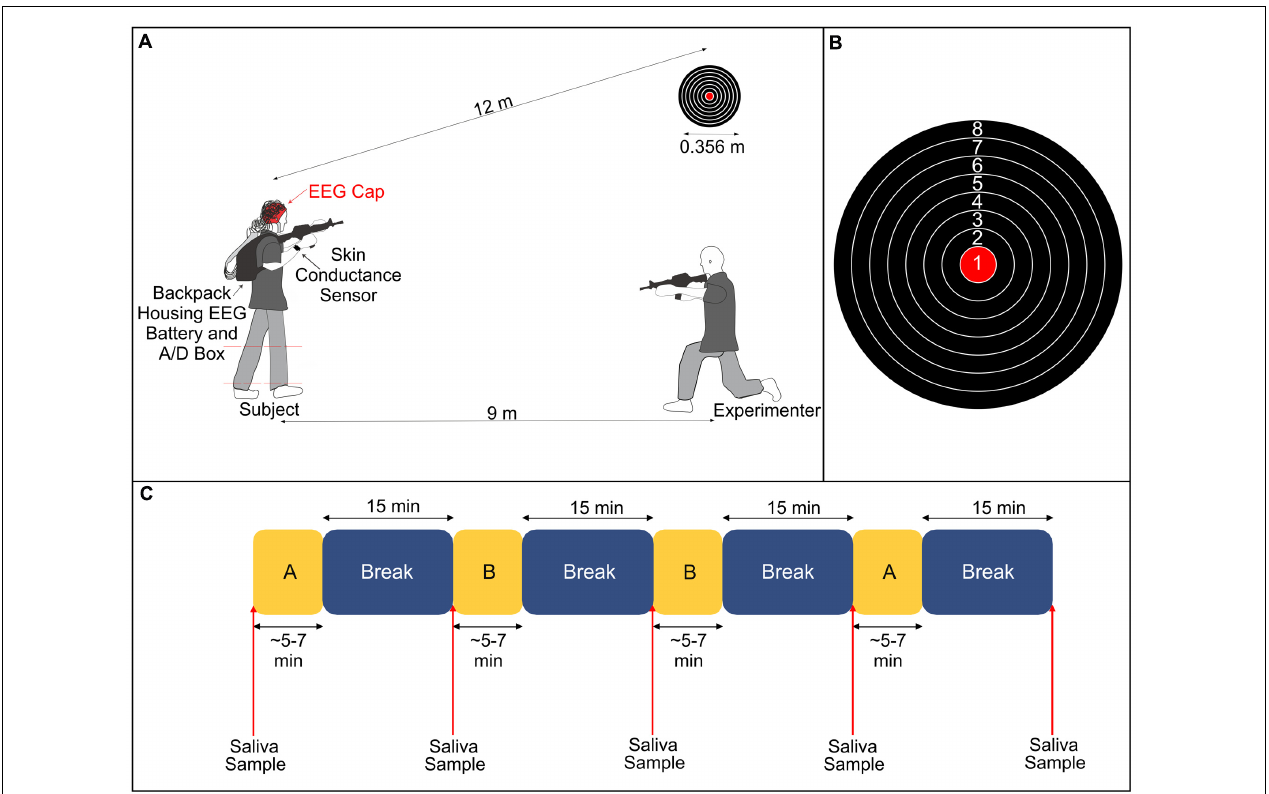
FIGURE 1 | (A) Illustration of experimental setup. The subject fired an airsoft rifle at a stationary target 12 m away during all conditions. During the Stress condition, an experimenter, positioned 9 m away and at a 30 ◦ angle from the target, fired a different airsoft rifle at the subject’s lower legs (dashed red lines denote the region that the subject was hit). (B) Diagram of the target and the numerical value associated with each gradation. (C) Breakdown of the experimental protocol. Subjects completed two blocks of each condition (A and B, representing either Stress or Control), with each block followed by a 15-min rest period. We took saliva samples immediately before starting the experiment and at the conclusion of each break. The lengths of A and B varied depending on the subjects’ self-selected